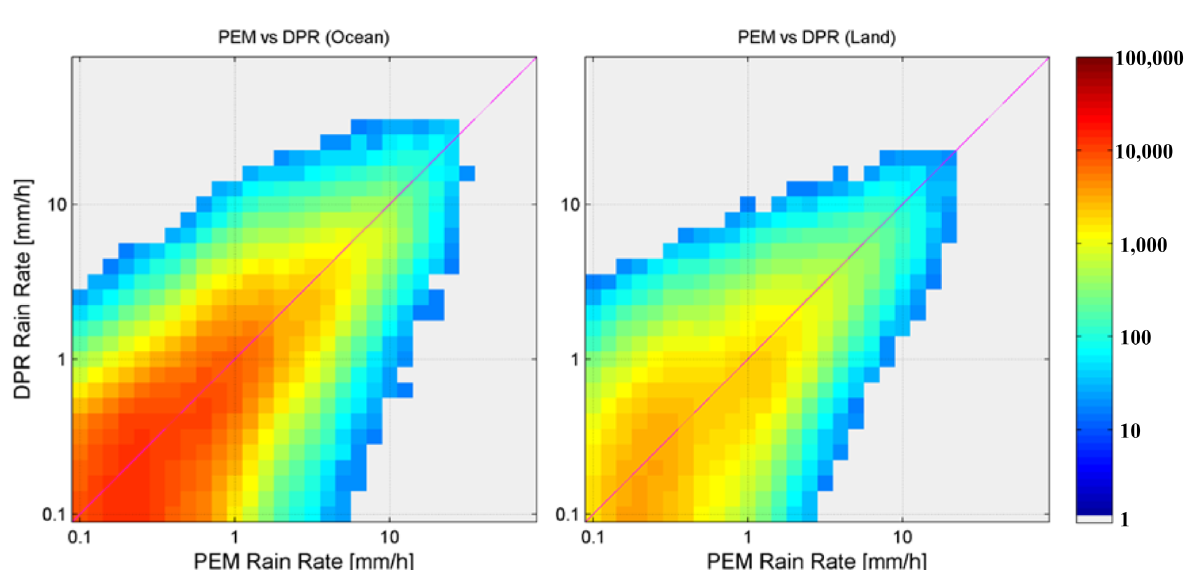
Figure 4. Density scatterplot of pixel-based comparison of surface precipitation rate estimates from the PEM and the corresponding DPR values in the verification dataset, over ocean ( left ) and land ( right ). Only pixels where both the NN and the dataset provide precipitation (hits) are shown. A logarithmic scale is used for the precipitation rates in mm/h, whereas colors represent the number of points in the dataset for each 2D precipitation rate bin (0.1